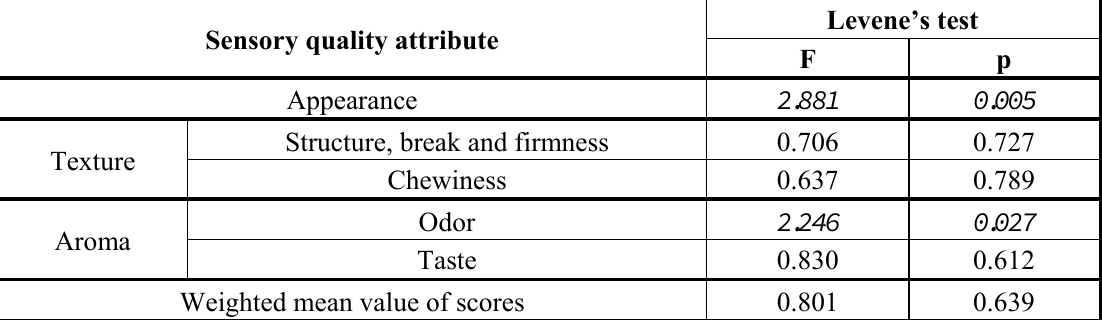
Table 2. Results of the Levene test for the homogeneity of variances of the praline samples with different